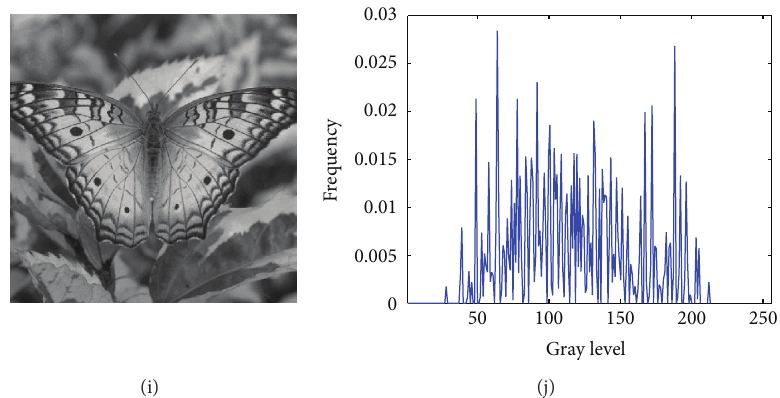
Figure 1: (a) Camera man, (c) Lena, (e) Baboon, (g) Hunter, and (i) Butterfly, the selected benchmark images. (b), (d), (f), (h), and (j) histograms of the